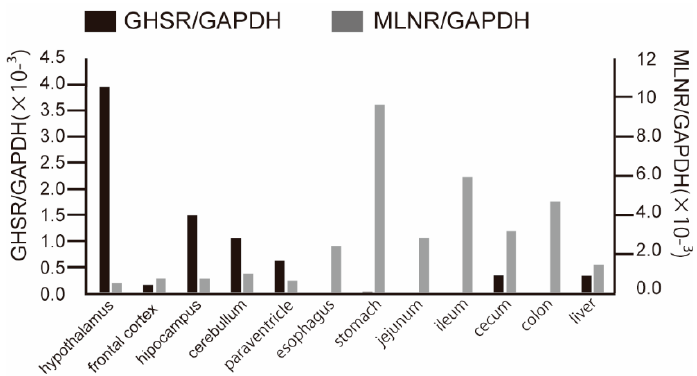
Figure 1. Accumulation of MLNR and GHSR transcripts in various tissues of human MLNR Tg mice ( n = 3). The values shown are the numbers for real-time RT-PCR products of MLNR and GHSR mRNAs normalized to those of GAPDH .